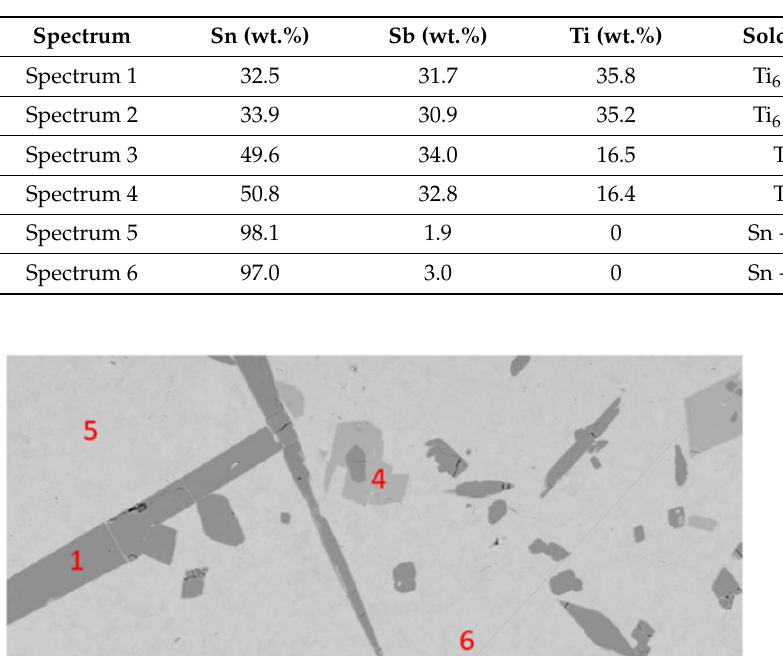
Figure 10 . Microstructure of the Sn5Sb3Ti phase; ( a ) from an optical microscope in the as-etched condition; ( b ) from SEM in BSE mode at a higher magnification. Table 4 . HV microhardness of individual components of the Sn5Sb3Ti solder . Table 5. EDX analysis of the Sn5Sb3Ti solder.